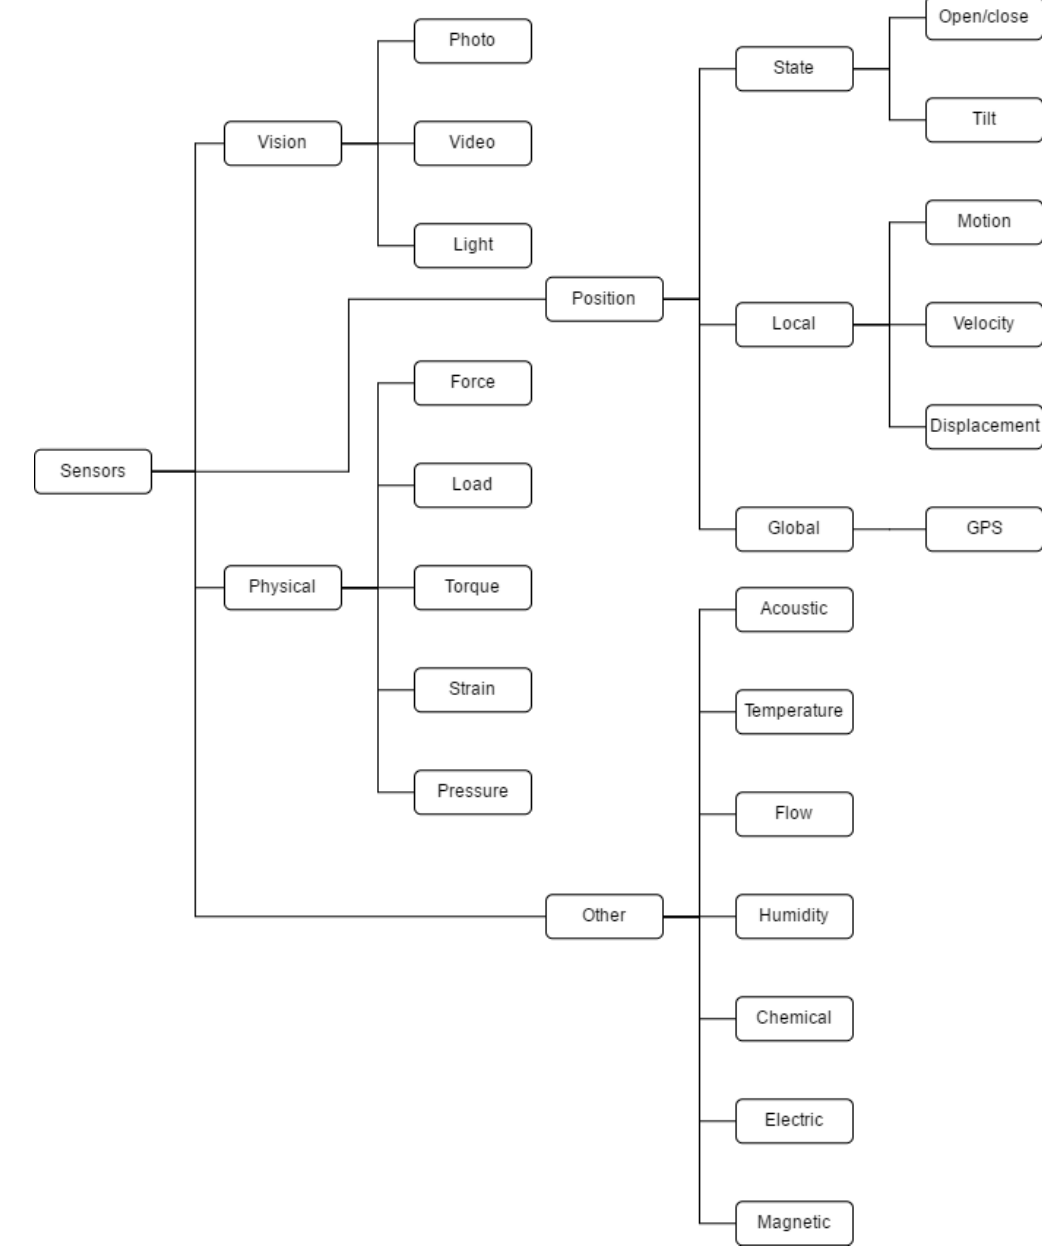
Figure 3. The Sensors category of the